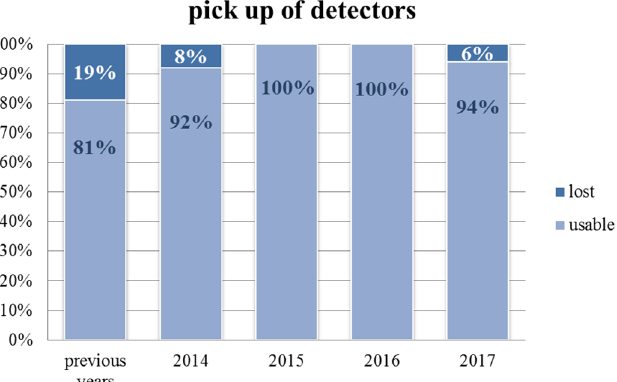
Fig. 4. Percentage pick-up rate of the